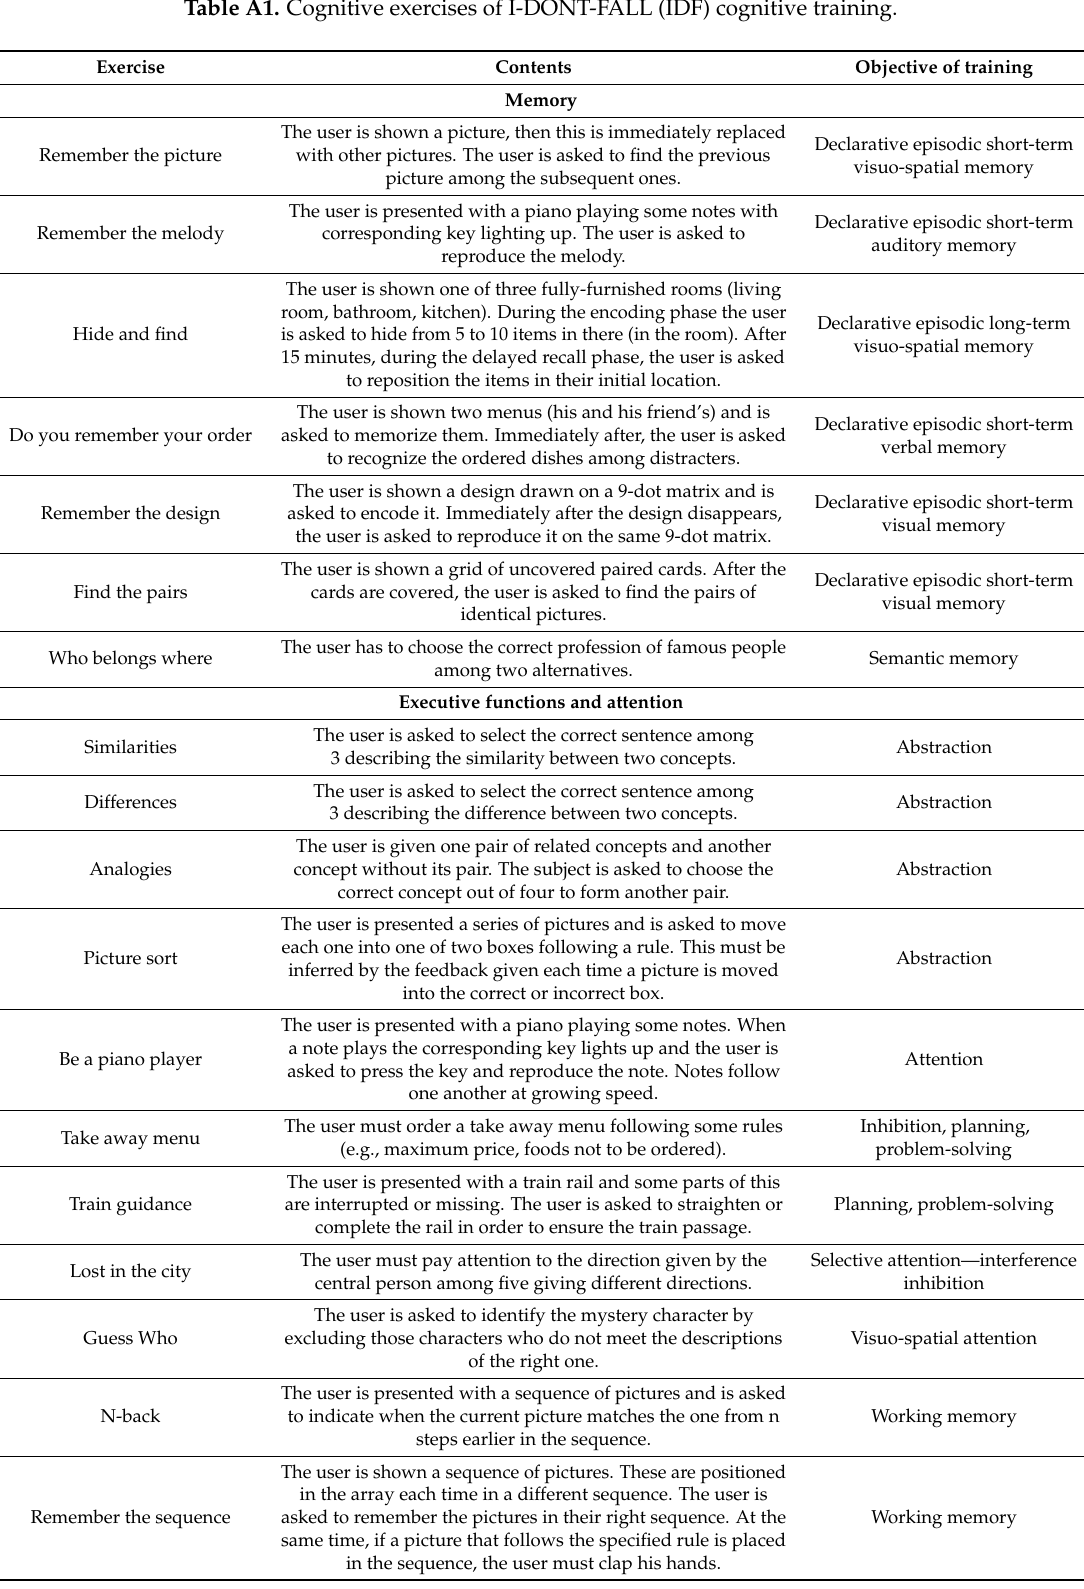
Table A1. Cognitive exercises of I-DONT-FALL (IDF) cognitive